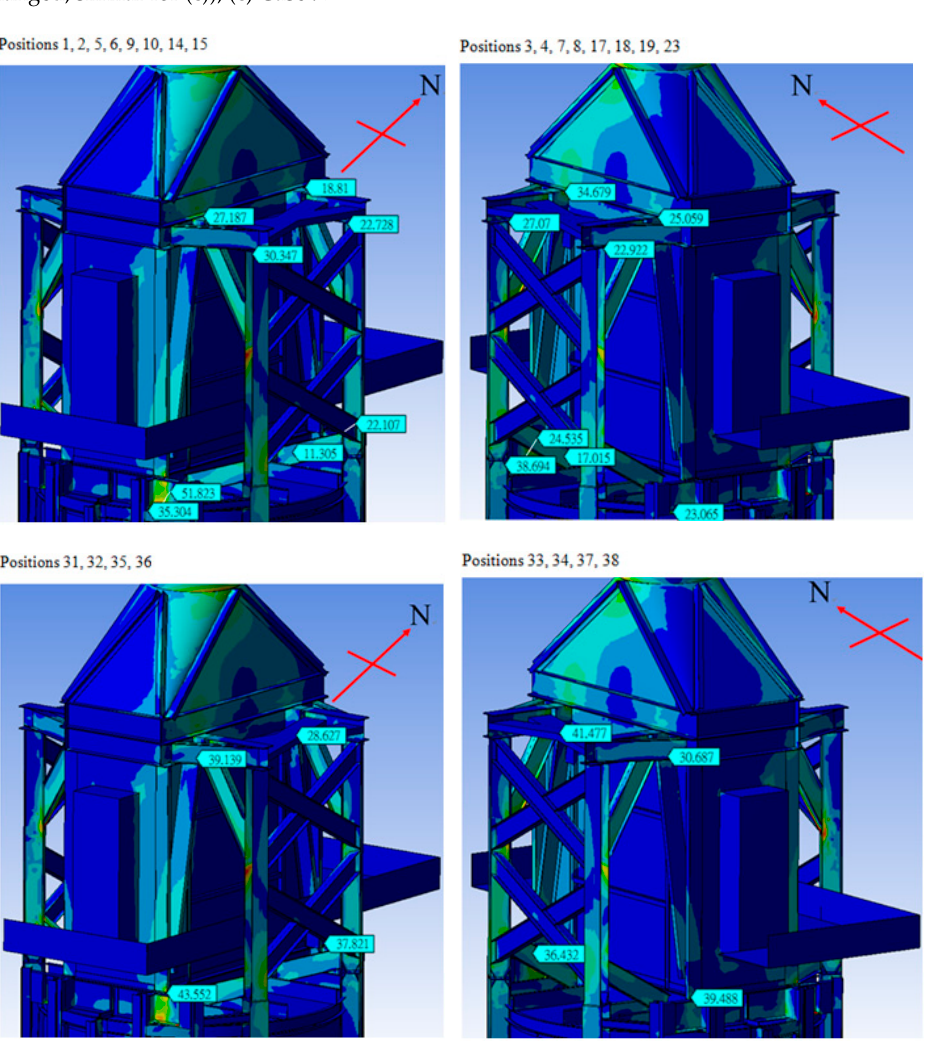
Figure 11. Results of finite element analysis for Case 9.